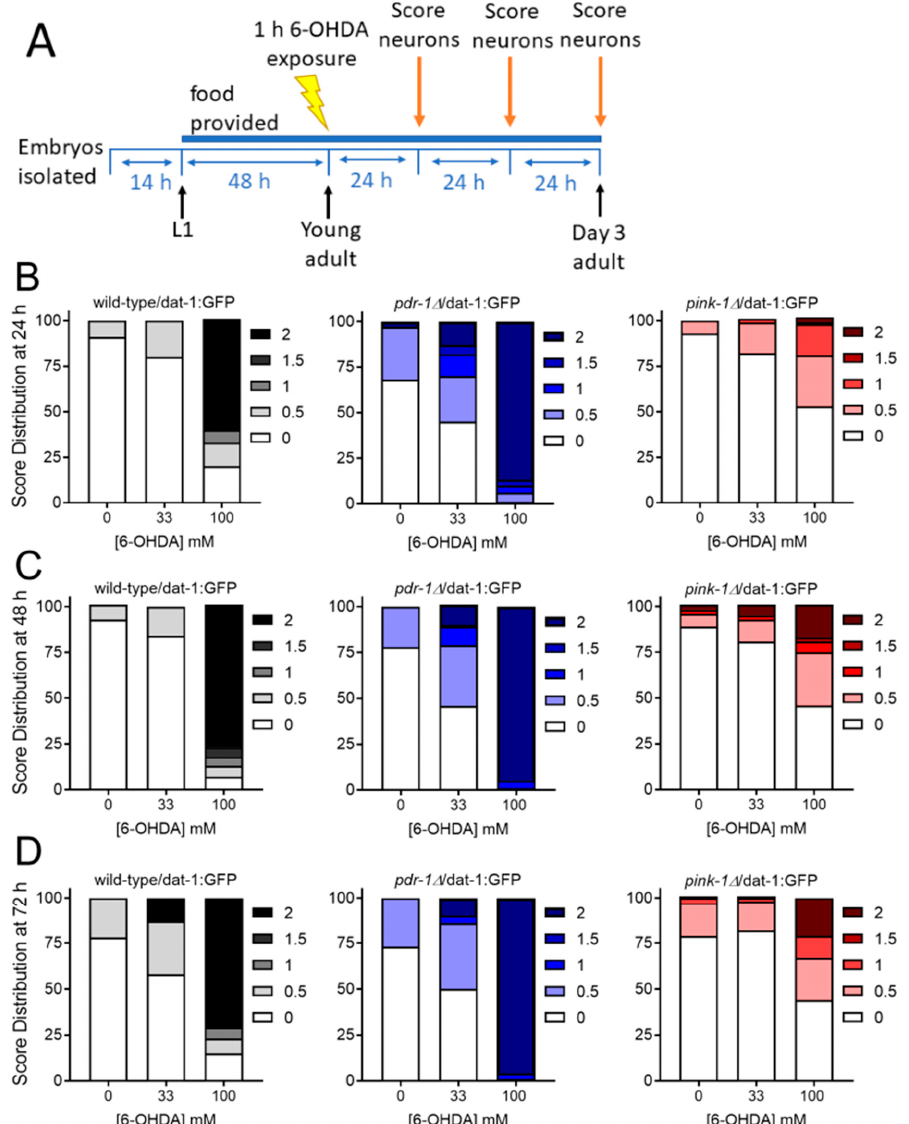
Figure 5. Loss of pdr-1 sensitizes nematodes to 6-OHDA, but loss of pink-1 is protective against 6-OHDA. For experiments, wild-type, pink-1 mutant, and pdr-1 mutant worms were exposed to 6-OHDA for one hour as young adults (Panel A ). Neurodegeneration was then measured 24 h (Panel B ), 48 h (Panel C ), and 72 h (Panel D ) following exposure. Scoring was performed as described in Methods: 0 represents no degeneration, while increasing numbers represent increasing severity of degeneration. Data shown are combined from three biological replicates with each treatment group comprising n > 30 worms scored for dendrites on each of 4 cephalic neurons for a total of >120 dendrites scored.